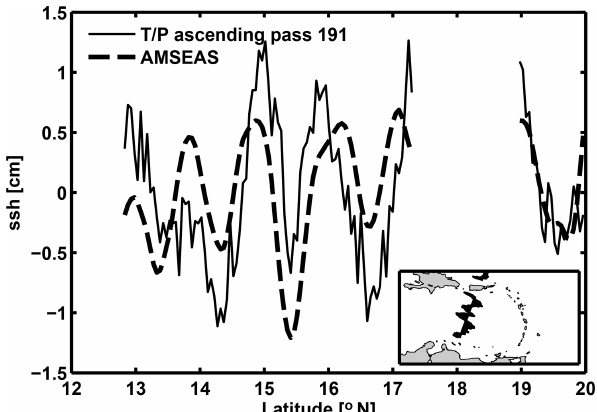
Figure 4. Internal tide along Jason-1 track no. 191. The in-phase component of the high-passed M 2 tide has maximum peak-to-peak amplitude of 1.5cm in AMSEAS (dashed) and slightly larger ampli- tude in the altimeter data (solid). Alignment of peaks and troughs is good, particularly near the apparent generation site, Mona Passage, west of Puerto Rico